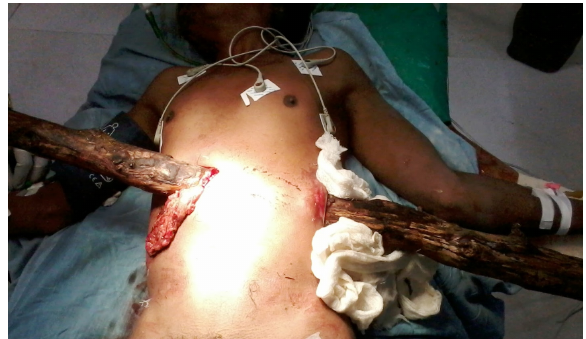
Figure 1. Photograph on admission showing bamboo stick injury of the